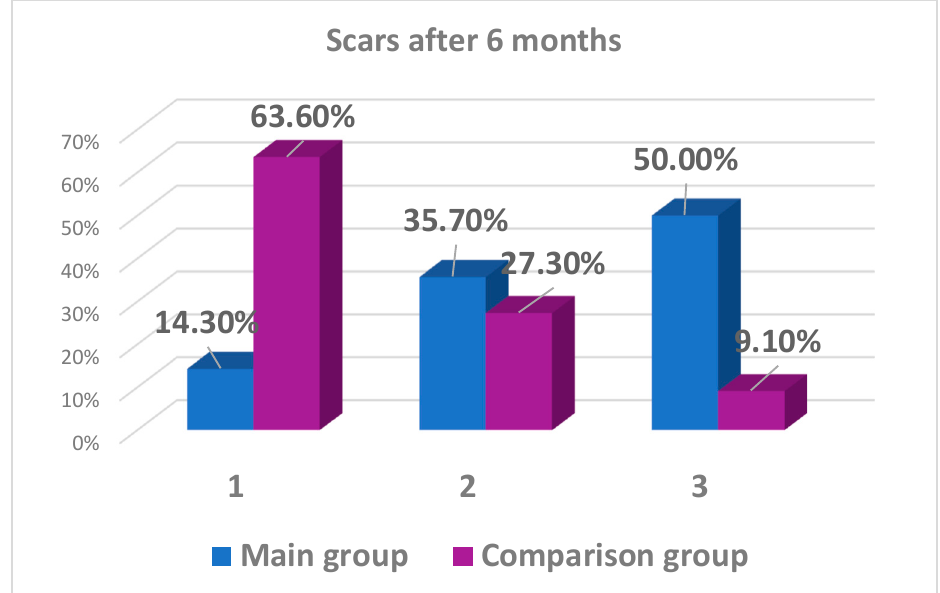
Figure 3. The wound healing after biopsy in the main group and the comparison group in 6 months, where 1 is a normotrophic, thin healed (white) scar; 2 is a wide healed (white) scar; 3 is a scar in the healing stage (red) (Pearson’s criterion χ 2 is 7.53, p -value = 0.023, Fisher's exact test p -value = 0.023).